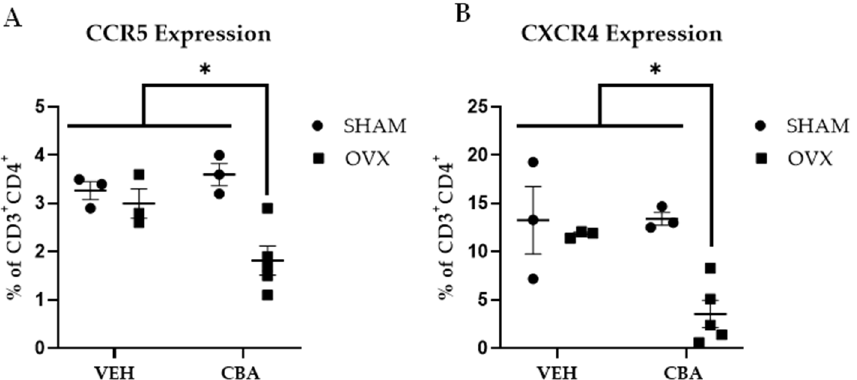
Figure 5. SIV co-receptor expression. CBA/OVX has significantly lower CCR5 and CXCR4 expression compared to all other experimental groups. ( A ). CCR5 expression is significantly decreased in CBA/OVX compared to all other experimental groups. ( B ). CXCR4 expression is significantly decreased in CBA/OVX compared to all other experimental groups. Vehicle (VEH)/sham surgery (SHAM) ( n = 3), VEH/ovariectomy (OVX) ( n = 3), chronic binge alcohol (CBA)/SHAM ( n = 3), and CBA/OVX ( n = 5). Two-way ANOVA and Tukey’s multiple comparison test. * p ≤ 0.05.